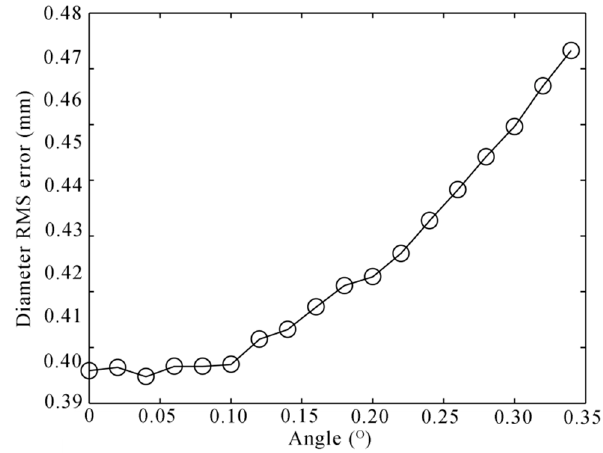
Figure 16. Diameter RMS error to the angle of the bend with the distance dL of 200 mm.